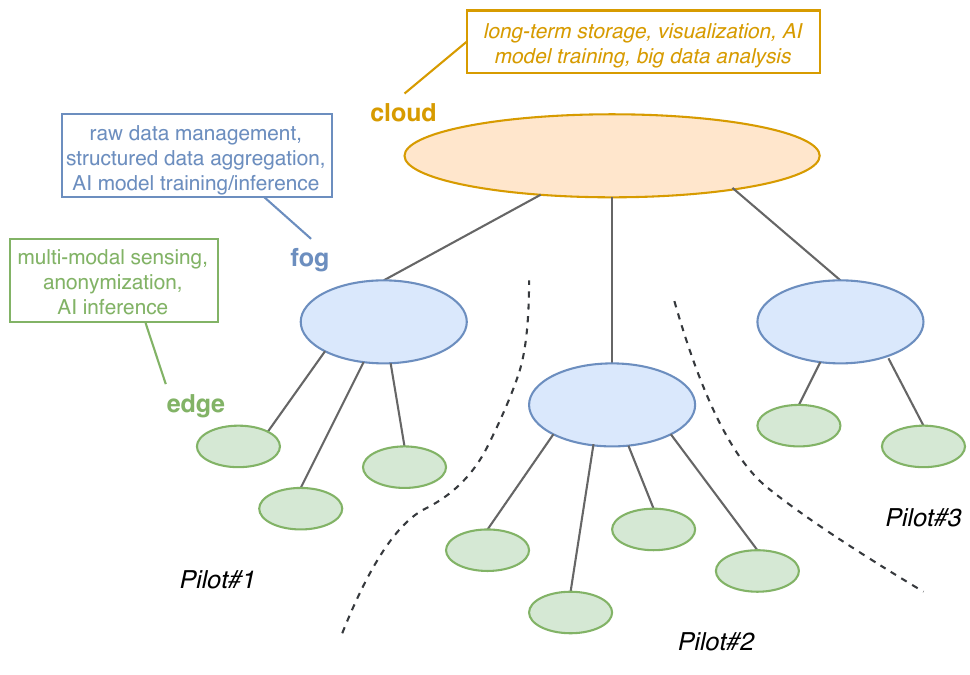
Figure 3. E2F2C view of the H2020 MARVEL project’s